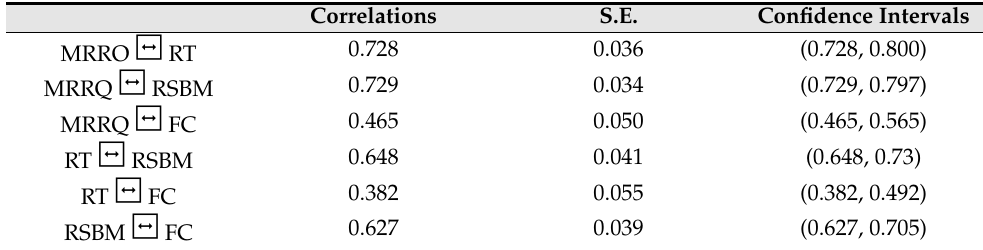
Table 6. Correlation and AVE results.